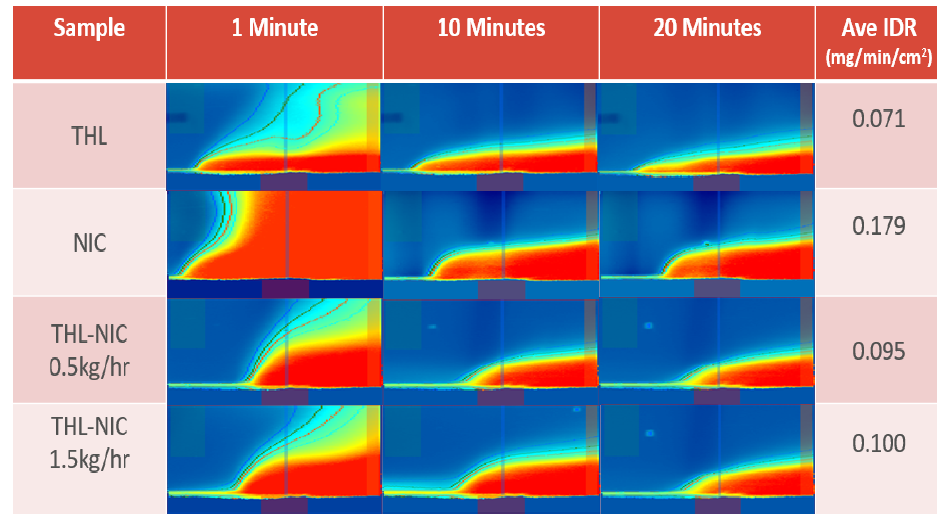
Figure 10. Graph showing the average intrinsic dissolution rate and UV images of bulk substances and extruded THL-NIC cocrystals surface dissolution after 1, 10 and 20